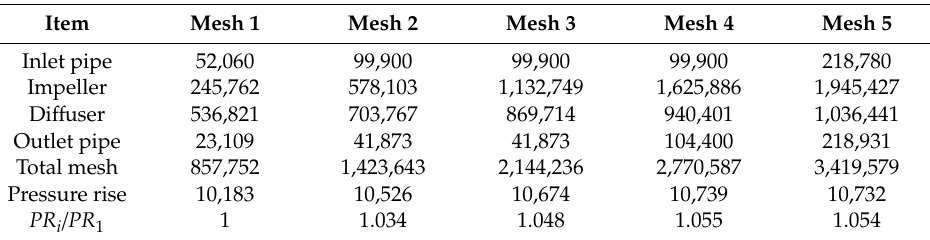
Table 3. Mesh independence